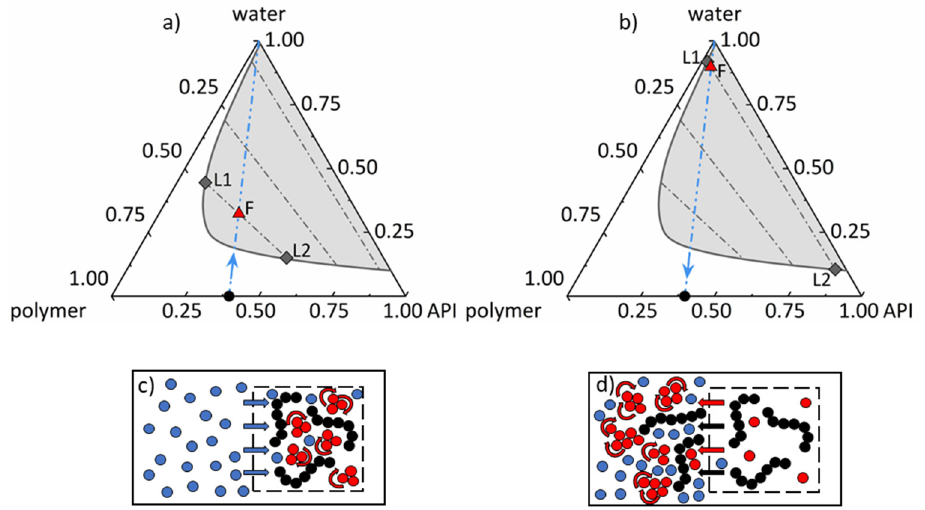
Figure 1. Schematic ternary phase diagram of an API/polymer/water system with schematic pathways of ( a ) water sorption and amorphous phase separation (according to ( c )) and ( b ) ASD dissolution in water and liquid–liquid phase separation (according to ( d )). The black circle depicts the dry ASD, and the blue dash-dotted line represents the path for ( a ) water sorption and ( b ) ASD dissolution. The gray solid line illustrates the miscibility gap (gray area) with gray dash-dotted tie lines. The red triangle denotes the feed point F for ( a ) amorphous phase separation and for ( b ) liquid–liquid phase separation. Gray diamonds denote the API-poor phase L1 and the API-rich phase L2.